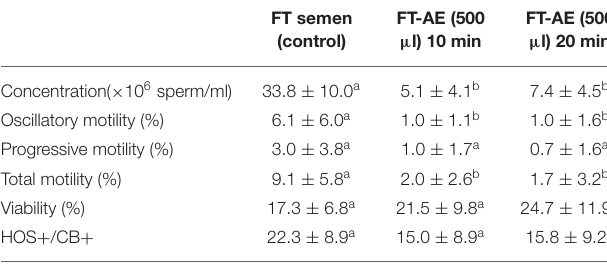
TABLE 4 | Sperm concentration, motility (oscillatory, progressive, and total), viability, and spermatozoa with functional membranes and an acrosome present (HOS + CB + ) in frozen-thawed (FT) llama semen (untreated control) and FT samples submitted to different centrifugation times (10 and 20min) through 500 µ l of Androcoll-E TM columns